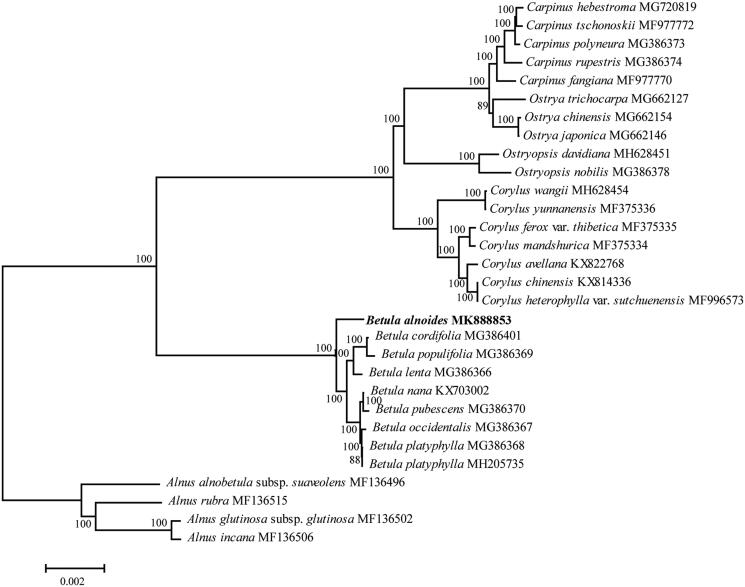
Phylogenetic tree based on chloroplast genomes using the ML method. Ultrafast bootstrap values are shown above the nodes, with 1000 bootstrap replicates. The chloroplast genome sequences of 29 species except for Betula alnoides were downloaded from theNCBI GenBank database (https://www.ncbi.nlm.nih.gov)".